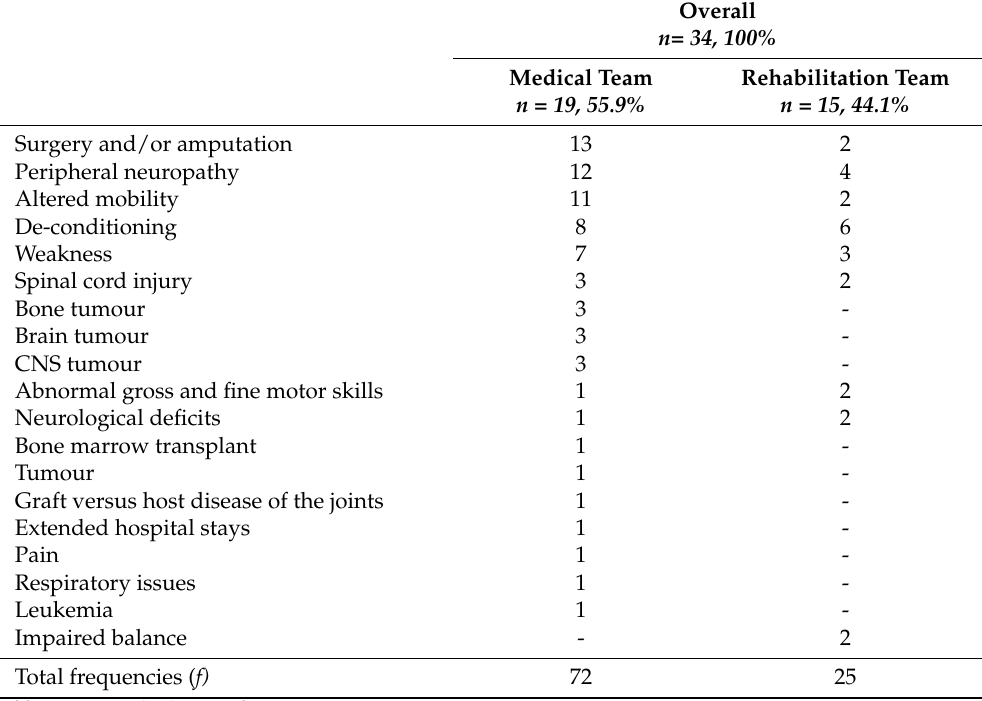
Table 3. Reasons that prompt referral to rehabilitation services.